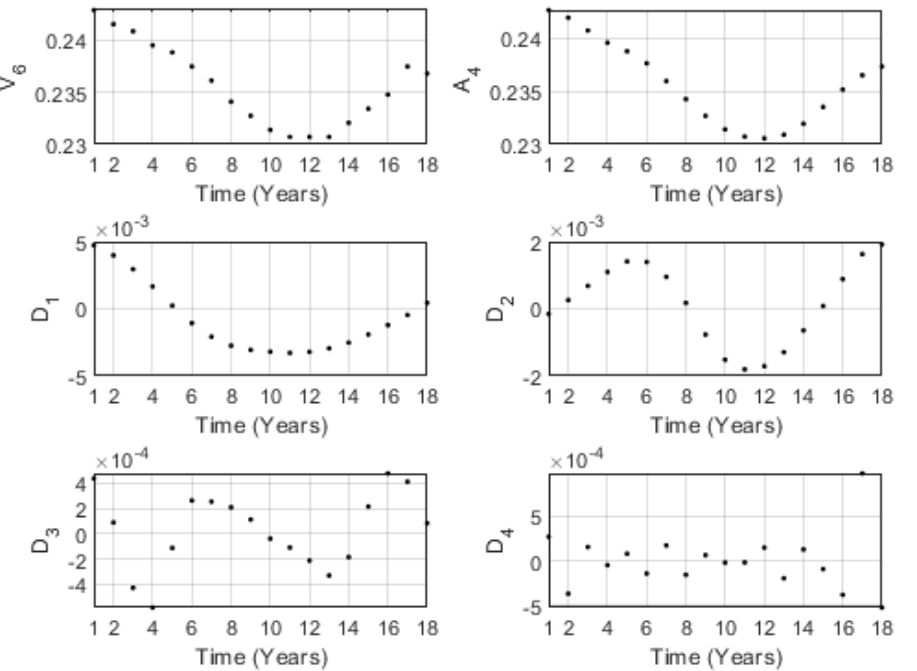
Figure 6. The wavelet decomposition of the variable V 6 at the level 4.